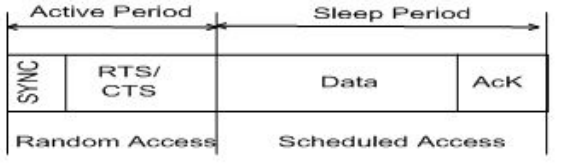
Fig. 4 Contents of a slot or frame for the proposed I-XLP protocol.